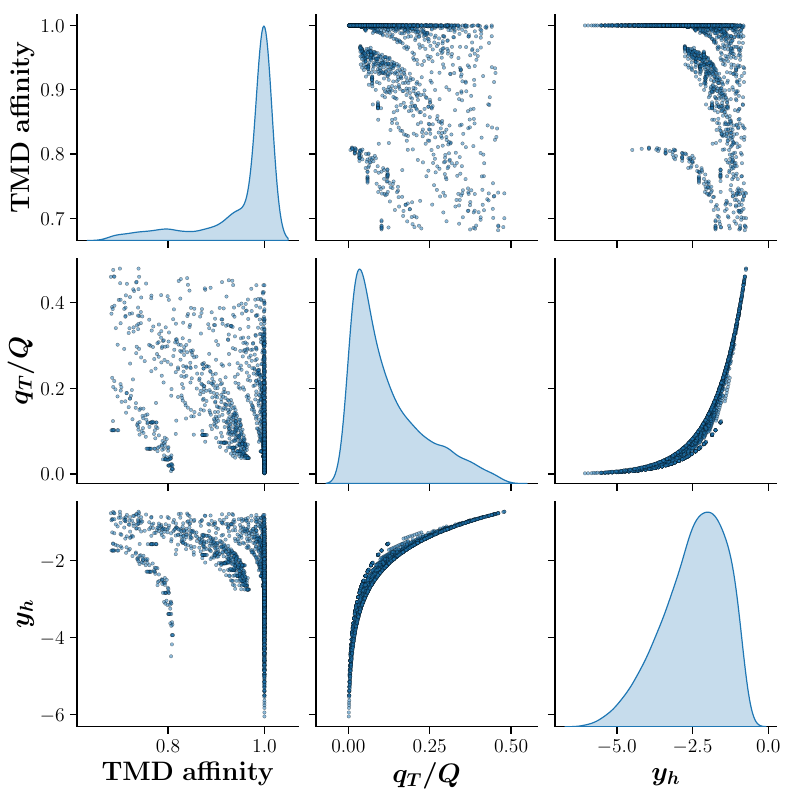
Figure 6 . Pair-wise correlations among TMD affinity greater than 70%, q T /Q , and the produced hadron rapidity y for EIC kinematics. The histograms on the diagonal help to visualize the relative h abundance of points in other pair-wise